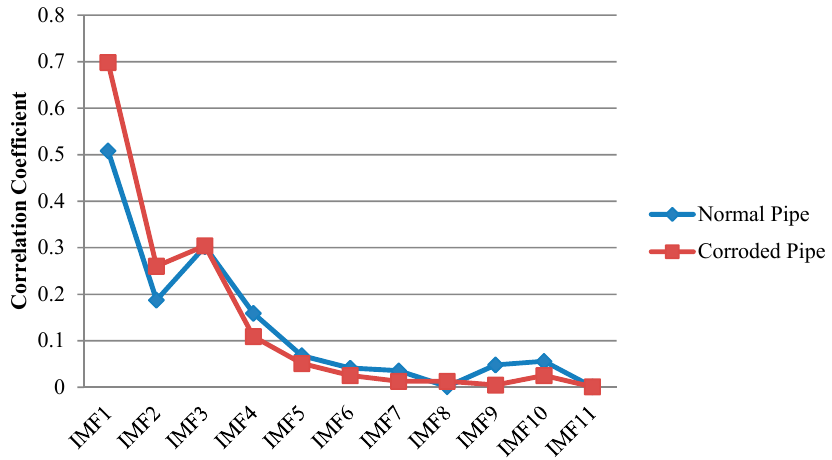
Figure 22. Absolute cross correlation of guided wave signals from the pipes in residential building with their corresponding IMFs obtained from SEMD.